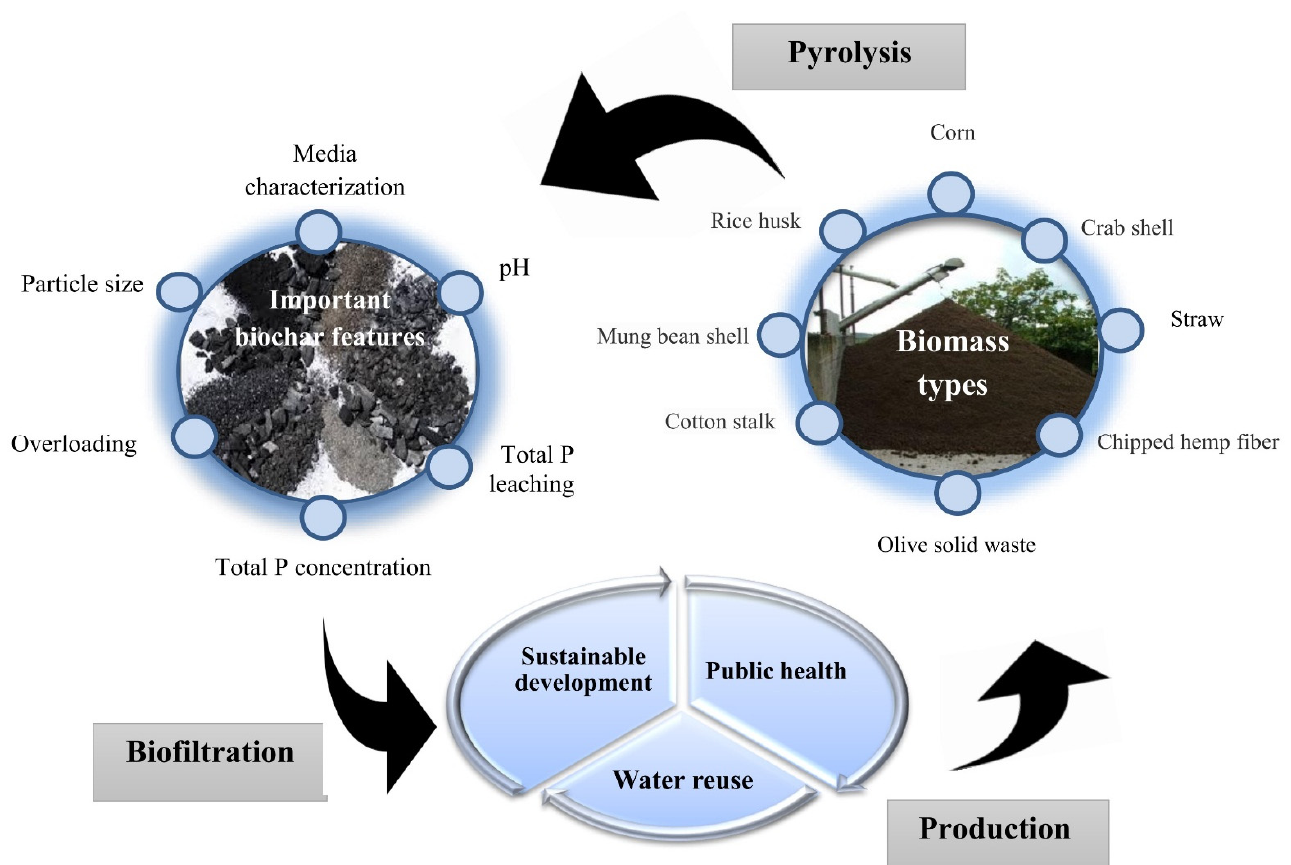
Figure 3. The cycle of biochar role on sustainable production and development in terms of wastewater application.